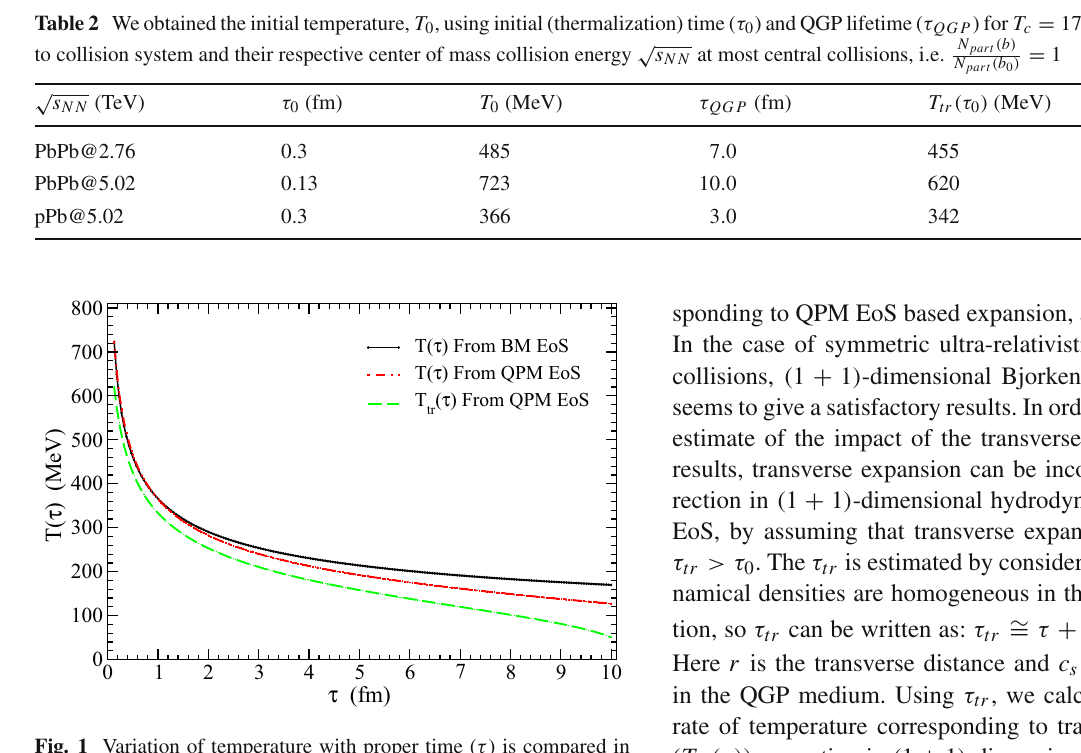
Fig. 1 Variation of temperature with proper time ( τ ) is compared in between ideal or Bag model (BM) equation of state and quasi-particle model (QPM) equation of state. The cooling rate of temperature cor- responding to transverse expansion ( T tr (τ) ) correction in (1 + 1)- dimensional QPM EoS is also